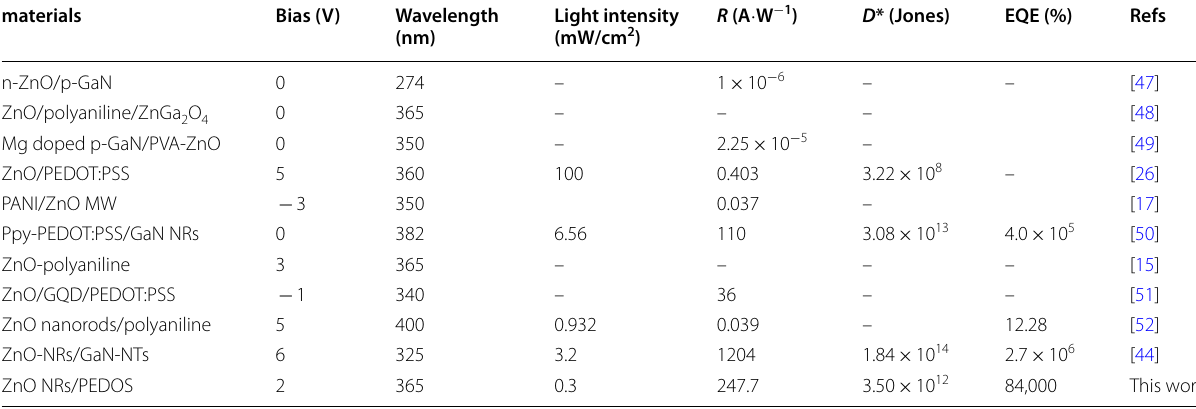
Table 2 Performance comparison of different ZnO-based UV PDs materials